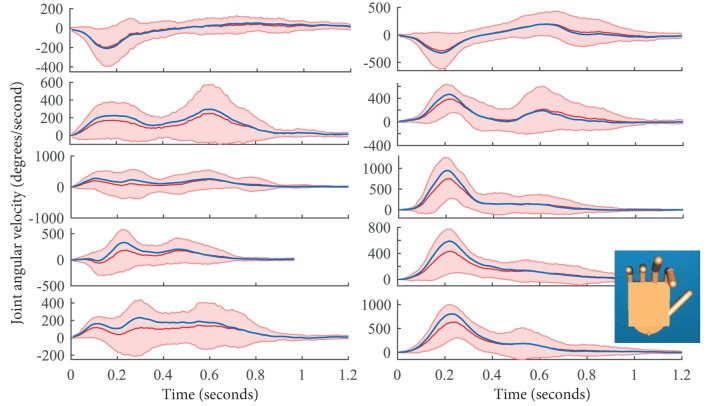
The red line shows the averaged joint movement across all 25 grasps in one repetition. SD is provided by the red shaded region. Metacarpophalangeal (MCP) and proximal interphalangeal (PIP) joints of the thumb (T), index (I), middle (M), ring (R), and pinky (P) are shown on the left and right, respectively. To show how the first synergy compares to the average movement, synergy 1 of this particular subject is overlaid by the blue line. Note that this synergy has been multiplied by a gain so that both the red and blue traces match for visual purposes only. The end posture of this synergy is shown on the bottom right. This is considered a postural synergy.